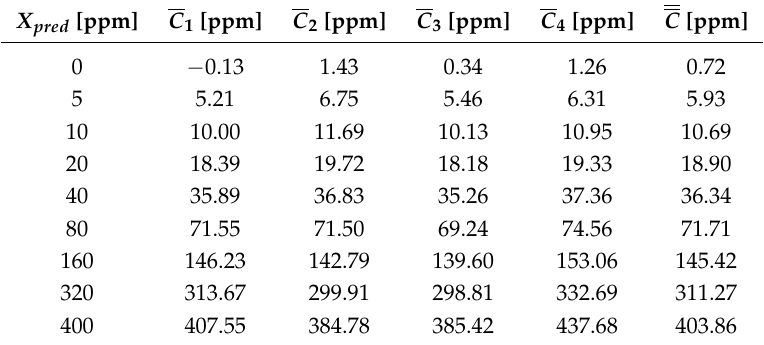
Table 11. Data of the experiment containing the predicted concentration, each steady-state value of the four OiW monitors based on WLS calibration, and the grand mean of all four monitors for each